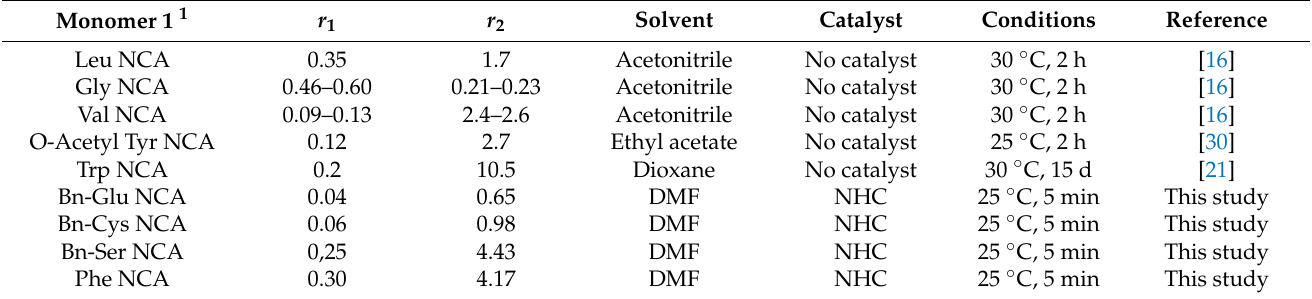
Figure 3. Proposed mechanism of NHC-initiated random copolymerization of Ala NCA with Bn-Glu NCA, Bn-Cys NCA, Bn-Ser NCA, and Phe NCA. Table 2. Reactivity ratios of Ala NCA for copolymerization with NCAs of some α -amino acids. Monomer 1